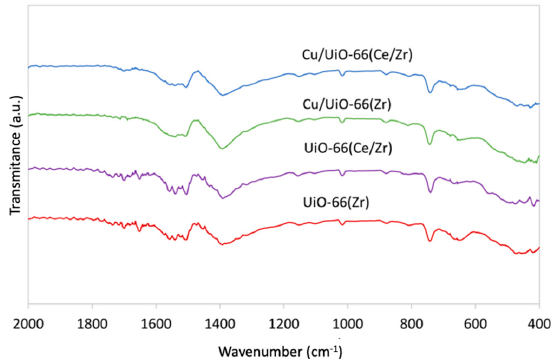
Figure 12. FT-IR of UiO-66 and Cu/UiO-66 materials after catalytic tests of MeOH synthesis.